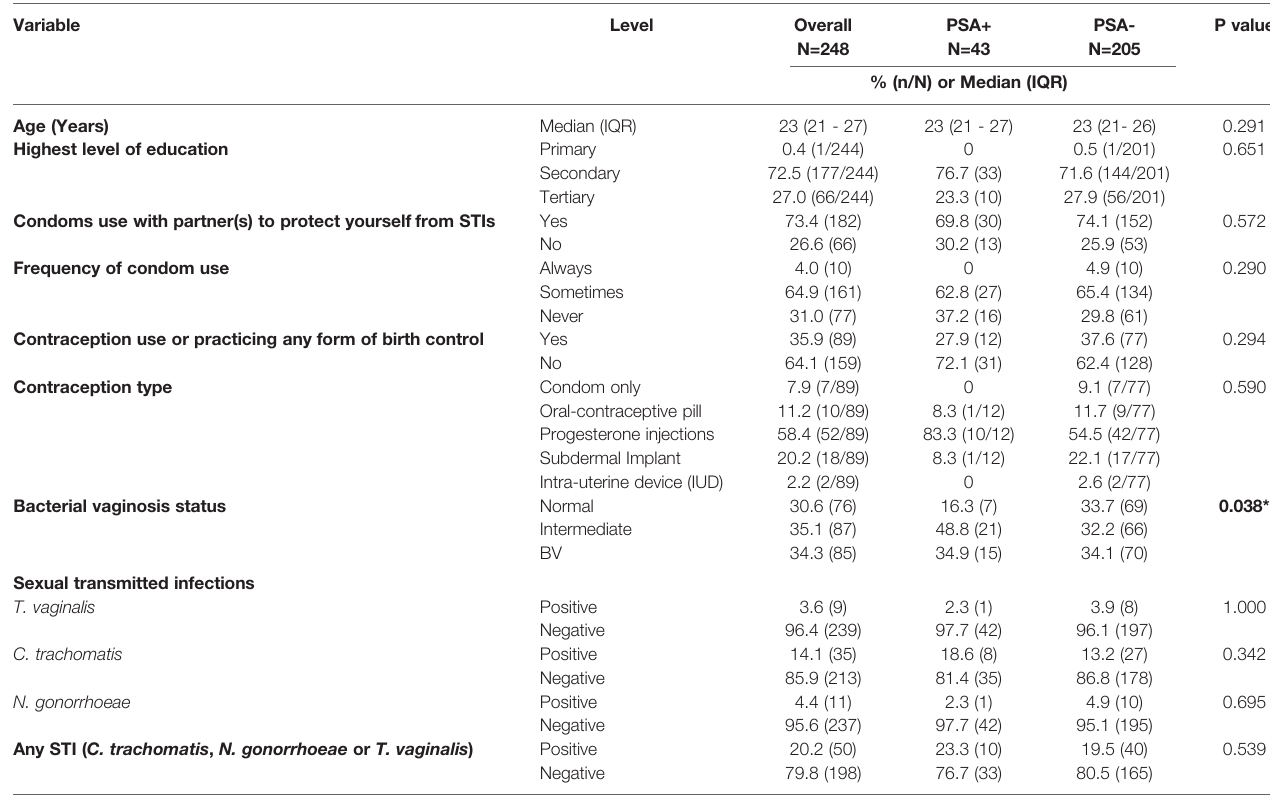
TABLE 1 | Baseline participant demographics according to presence of PSA in genital secretions.